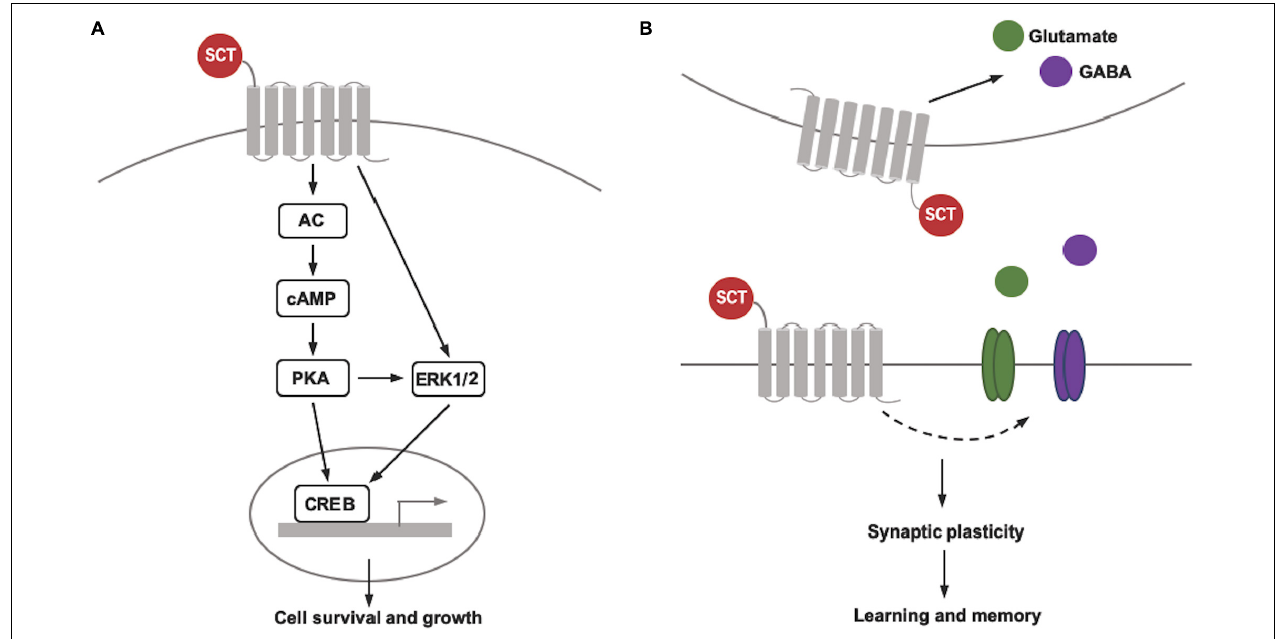
FIGURE 1 | Schematic diagram showing SCT’s pleiotropic actions on cell survival and synaptic plasticity. (A) SCT/SCTR signaling pathway that contributes to the cell survival and growth. (B) Bidirectional regulation of synaptic plasticity of SCT via different pre- and post-synaptic mechanisms.